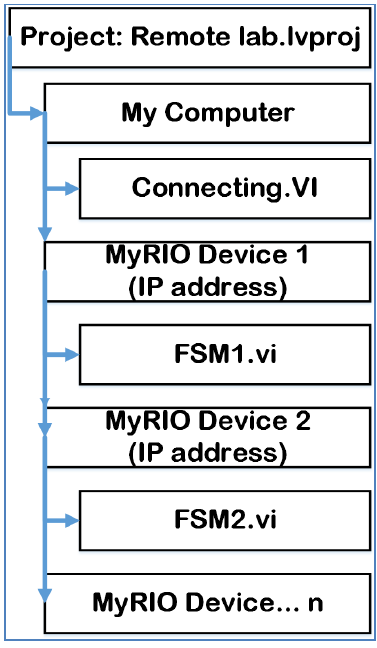
Figure 4. LabVIEW Project Hierarchy.